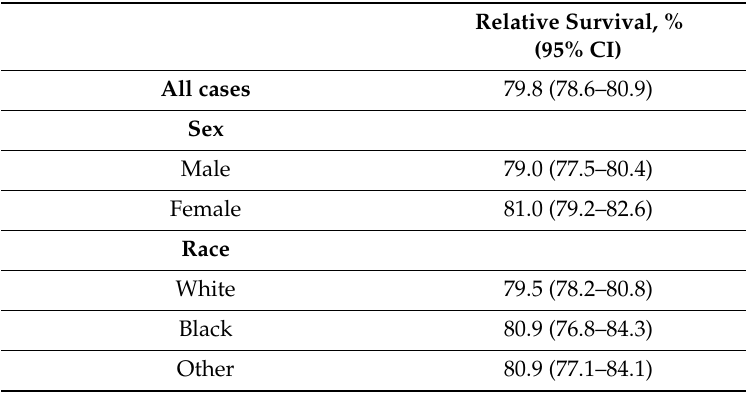
Table 4. Five-year survival of patients with liposarcoma: SEER,